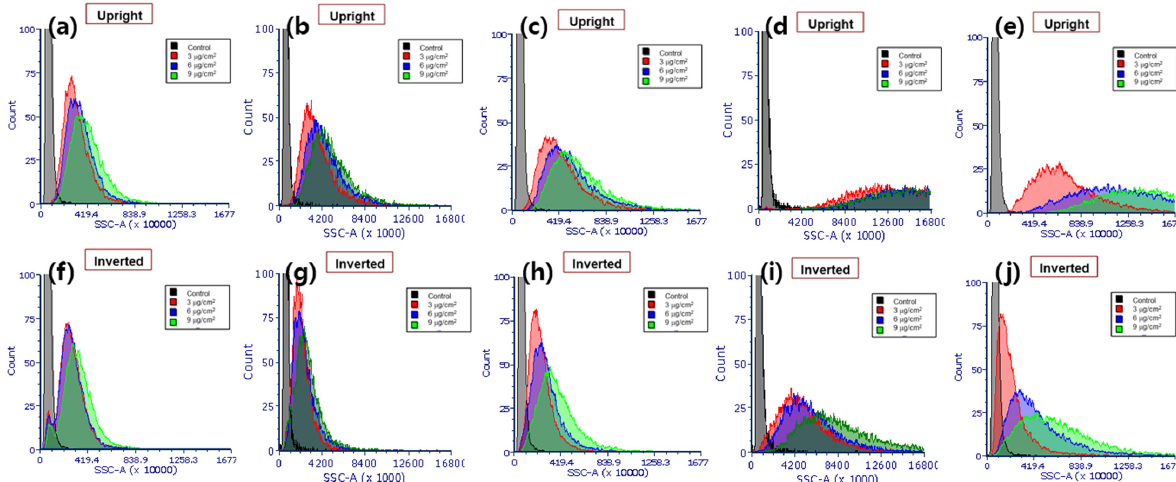
Figure 2. FCM-SSC intensity histograms of A549 cells exposed to ( a , f ) Ag 40 , ( b , g ) Ag 60 , ( c , h ) Ag 80 , ( d , i ) Ag 100 , and ( e , j ) Ag 200 NPs under upright ( a – e ) and inverted ( f – j ) configurations.